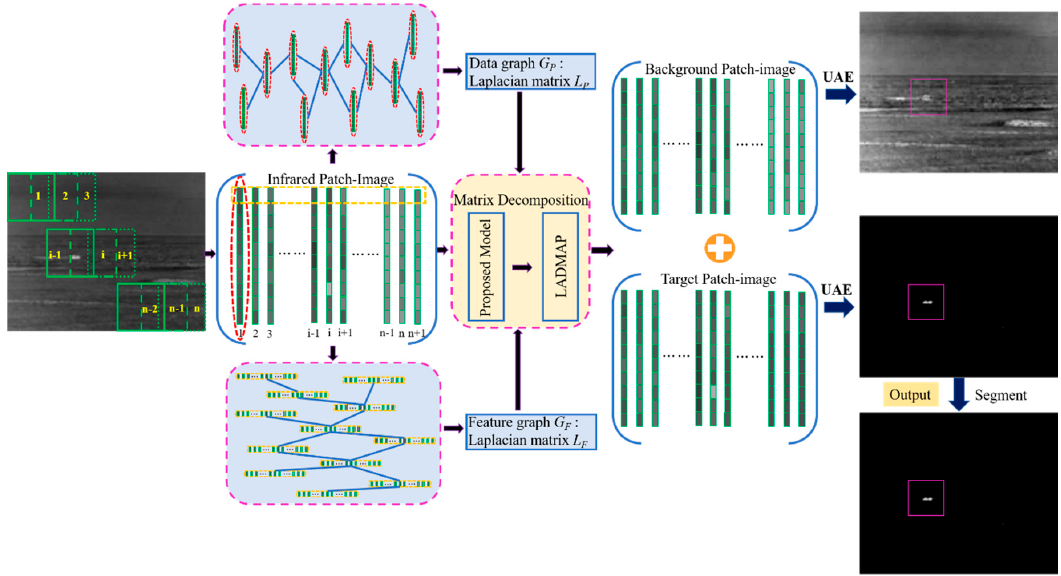
Figure 3. Illustration of the proposed model for infrared small target extraction.